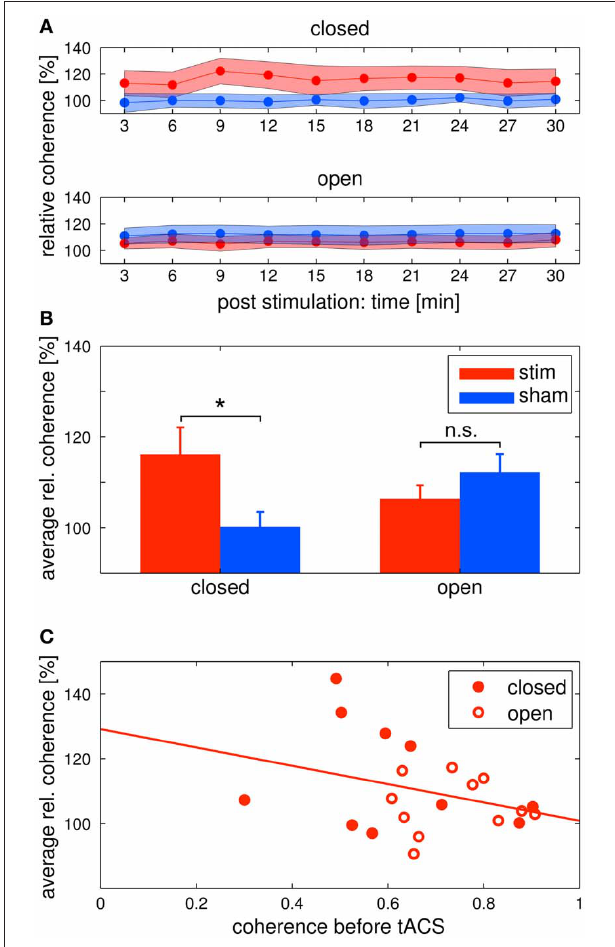
FIGURE 6 | Changes in alpha coherence. Red: tACS stimulation group, blue: sham stimulation group. (A) Timecourse of coherence after stimulation: change of the alpha coherence over the whole post EEG block. Solid lines depict the mean, shaded areas depict the standard deviation. Upper: closed eyes, lower: open eyes. (B) Relative difference in coherence after stimulation: average alpha coherence of the whole post EEG block. Solid lines depict the mean, shaded areas depict the standard deviation. Bars indicate the mean ± SEM, asterisks indicate significant differences. In the closed eyes condition, alpha coherence was increased in the tACS stimulation group compared to the sham stimulation group. (C) Correlation of pre alpha coherence and coherence chance post stimulation: lower pre stimulation coherence yields higher coherence increases after tACS. Red discs: participants of the eyes closed experiment, red circles: participants of the eyes open experiment. The solid red line depicts the regression curve.